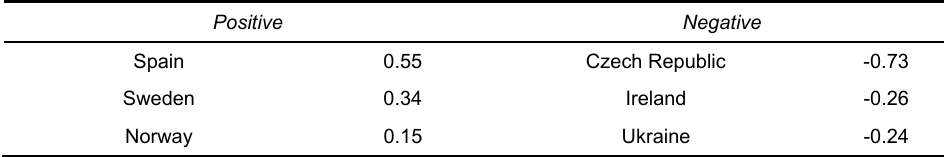
Table 1: Largest changes in net self-transcendence between ESS1 and ESS5